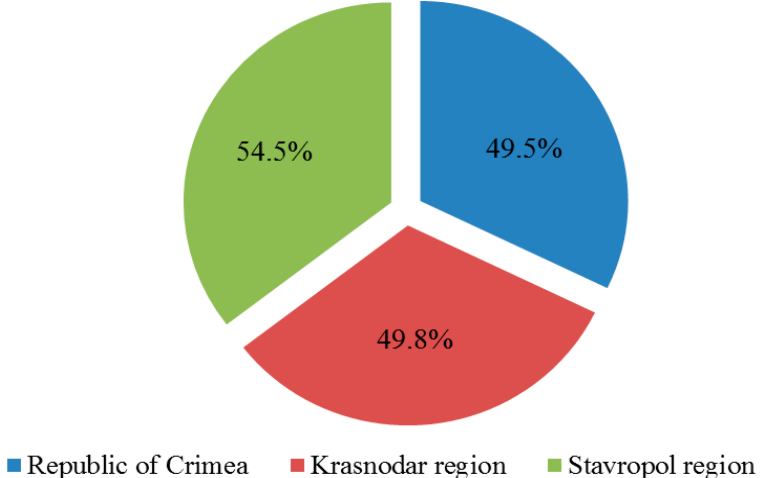
Figure 2. The number of affected grape plants in the vineyards of the surveyed territories (percentage of the total number of samples collected in the region).